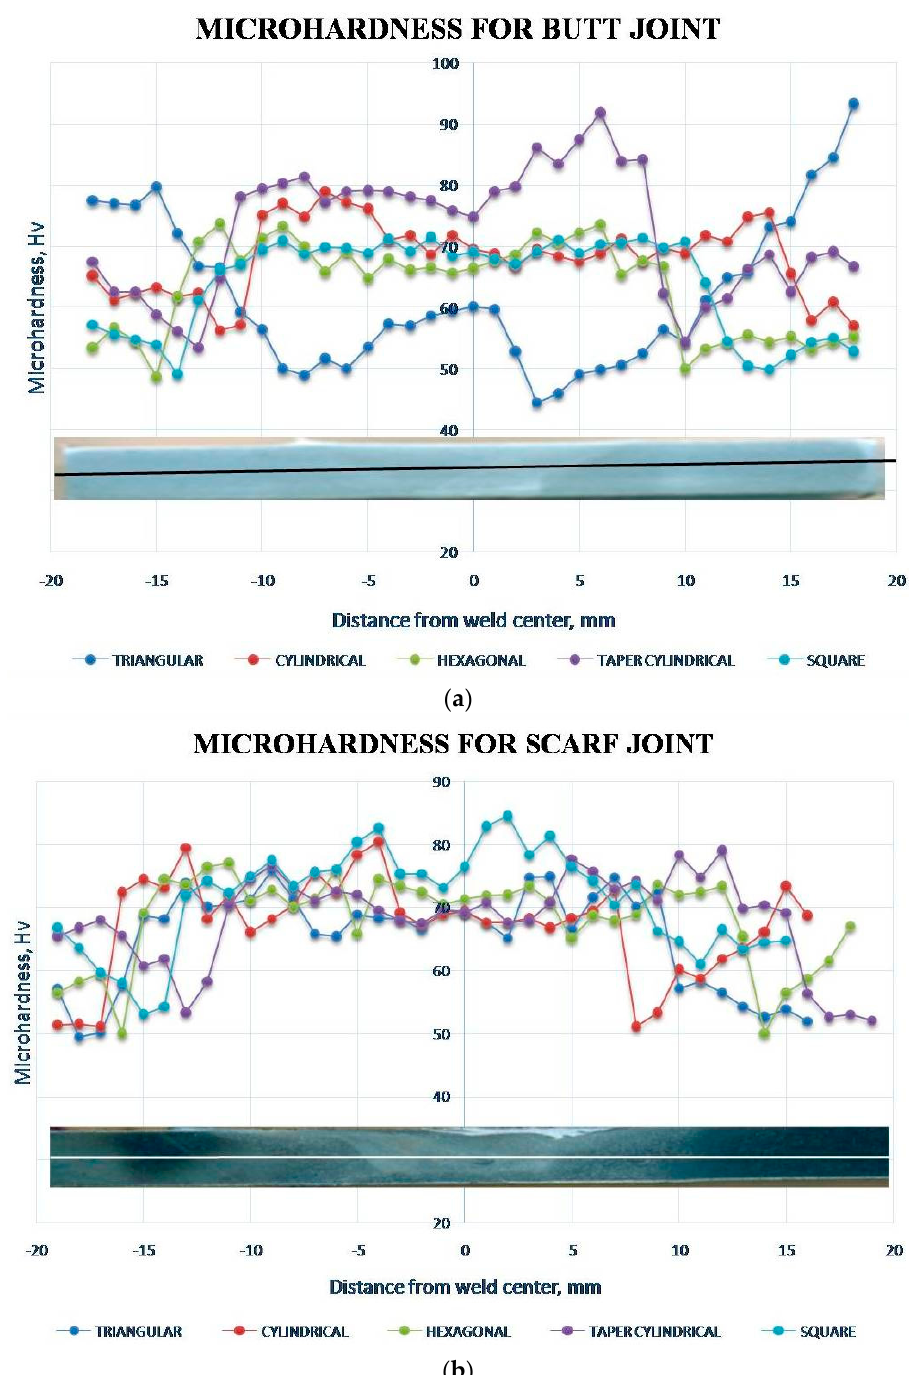
Figure 11. Micro hardness profiles of welded joints produced in ( a ) butt joint configuration and ( b ) scarf joint configuration.